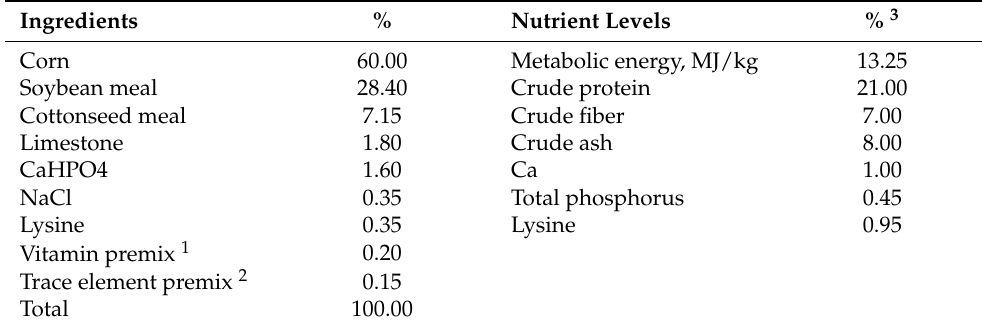
Table 1. Composition and nutrient levels of the basal diet (air-dry